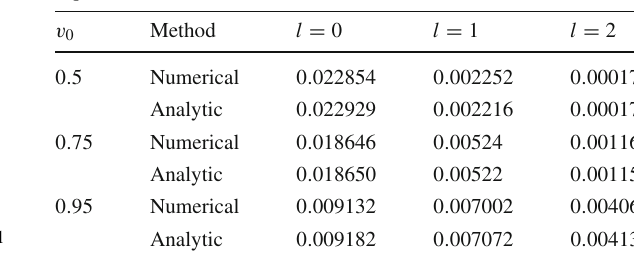
Table 1 Spectra of the energy radiated to infinity in the ZFL for multi- pole numbers l = 0 , 1 , 2, considering the source released from infinity with non-vanishing initial velocity. We compare the results obtained numerically by using Eq. (10) with the ones obtained analytically in